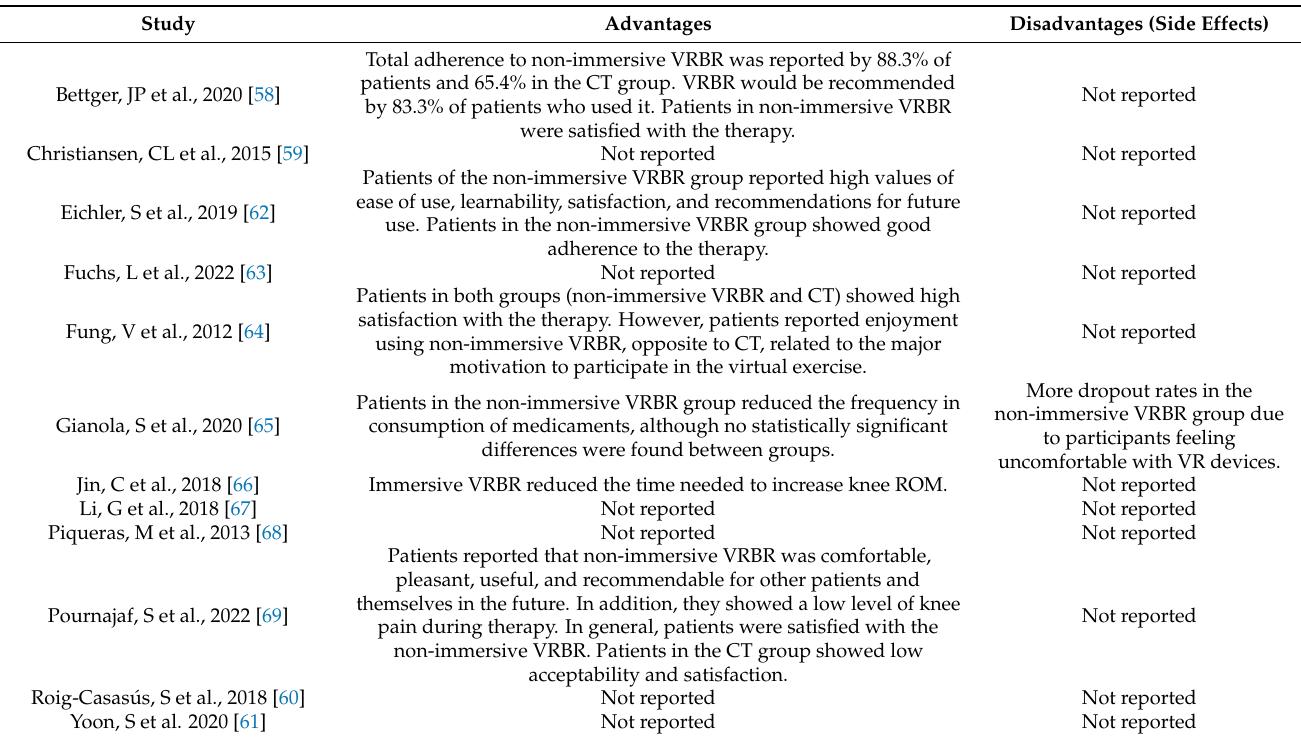
Table 5. Advantages and disadvantages of VRBR in the studies